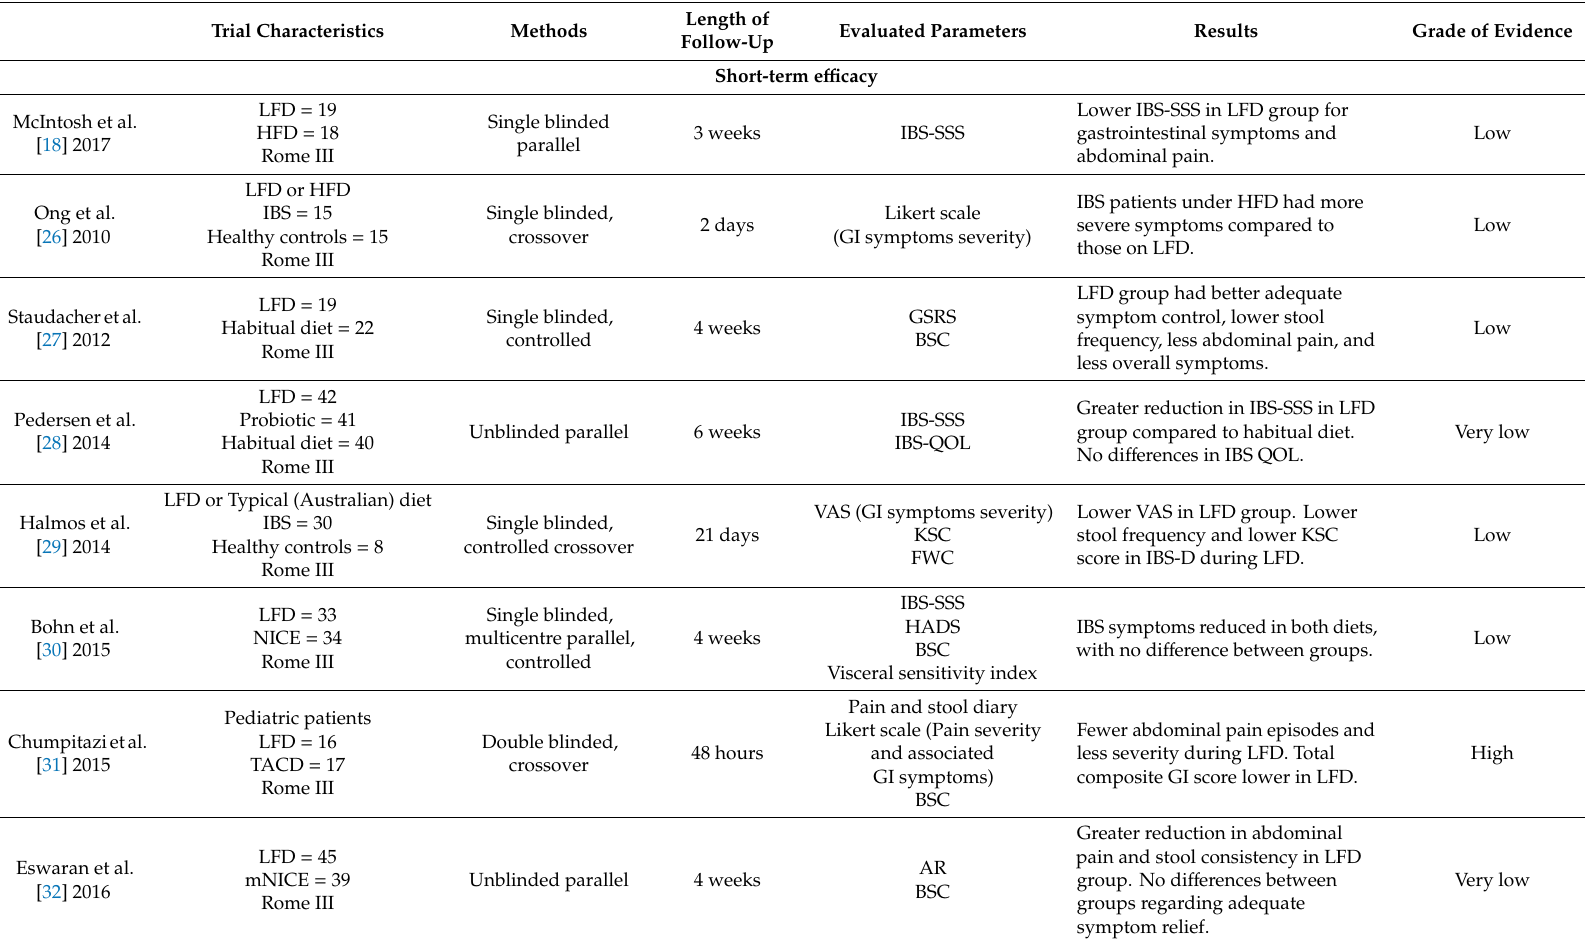
Table 1. LFD e ffi cacy in